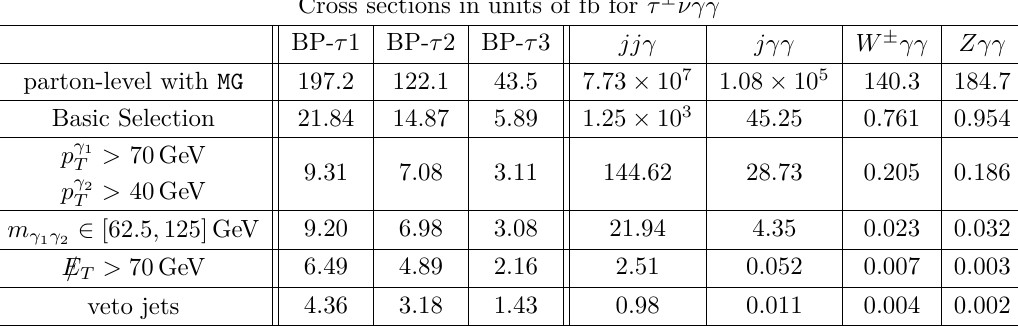
Table 3 . The cut-flow of the cross sections (in units of fb) for the final state τ ± νγγ and the back- grounds at the 14 TeV LHC. The parton-level cross sections are obtained using the MadGraph5 with the default run_card requiring p γ > 10 GeV , p j > 20 GeV , and | η γ,j | < 5 . The final step is T T to veto jets with p T > 20 GeV and | η | < 2 . 5